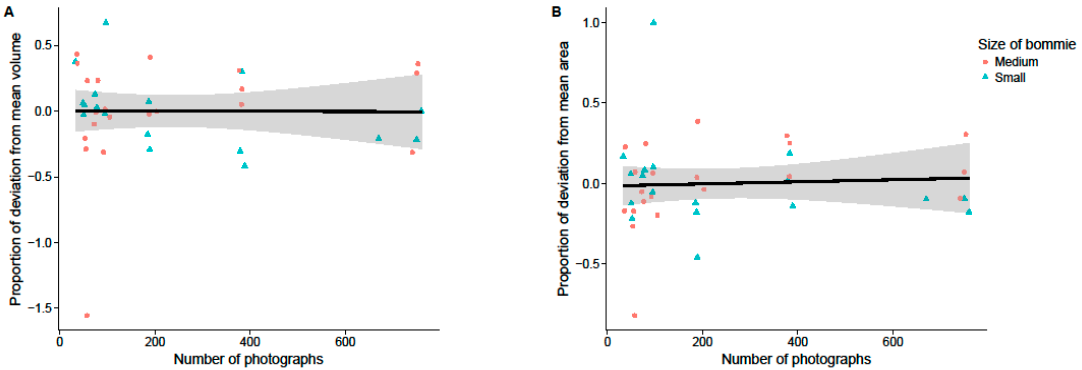
Figure 5. Relationship between the number of photographs taken and the deviation from the mean ( A ) volume and ( B ) surface area of measured bommies ( n = 9). The shaded area represents 95% confidence interval of linear regression (black line).